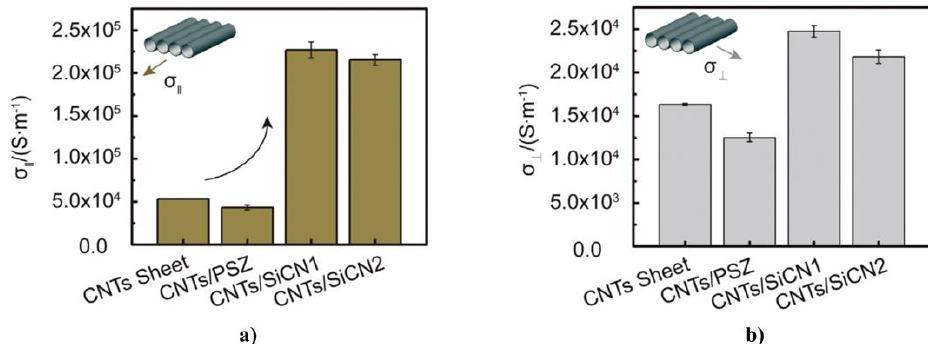
Figure 36. Electrical conductivity of aligned CNT nanocomposites: ( a ) parallel to the CNT alignment direction and ( b ) normal to the CNT alignment direction. Reprinted from [108], Copyright 2016, with permission from Elsevier.